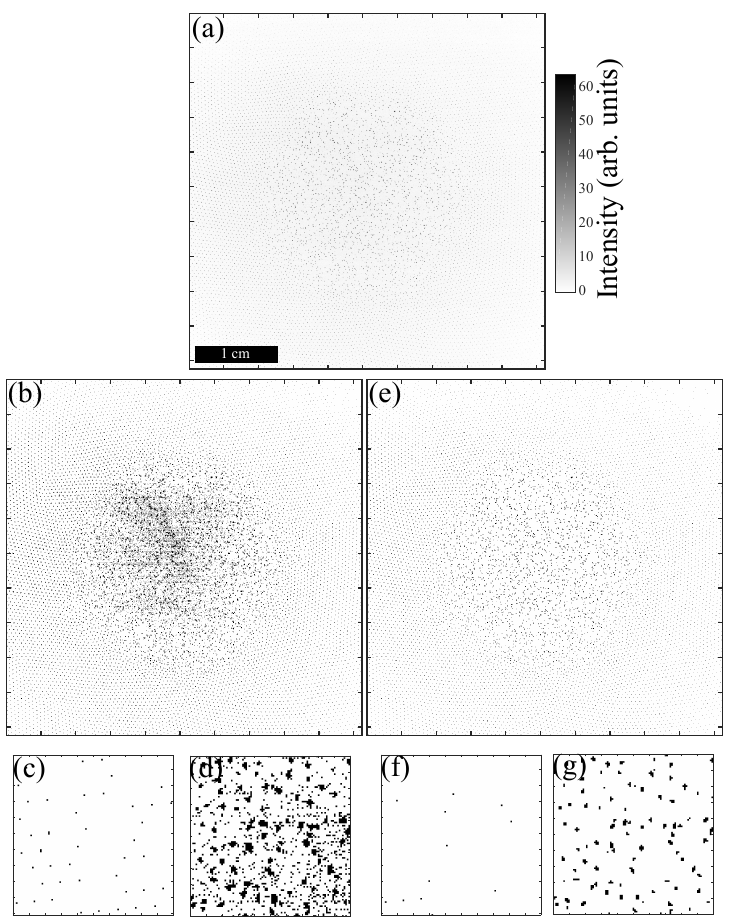
Figure 2. ( a ) Original frame (the intensity map was inverted for clarity); ( b ) Binary image obtained with a threshold of 3; ( c ) zoom of ( b ) at the top left corner of the frame; ( d ) zoom of ( b ) in the centre of the frame; ( e ) Binary image obtained with a threshold of 6; ( f ) zoom of ( e ) at the top left corner of the frame; ( g ) zoom of ( e ) in the centre of the frame. Note that the grey scale of the original image has been changed from 0–255 to 0–64 for better visibility (pixels artificially saturate if their intensity is greater than